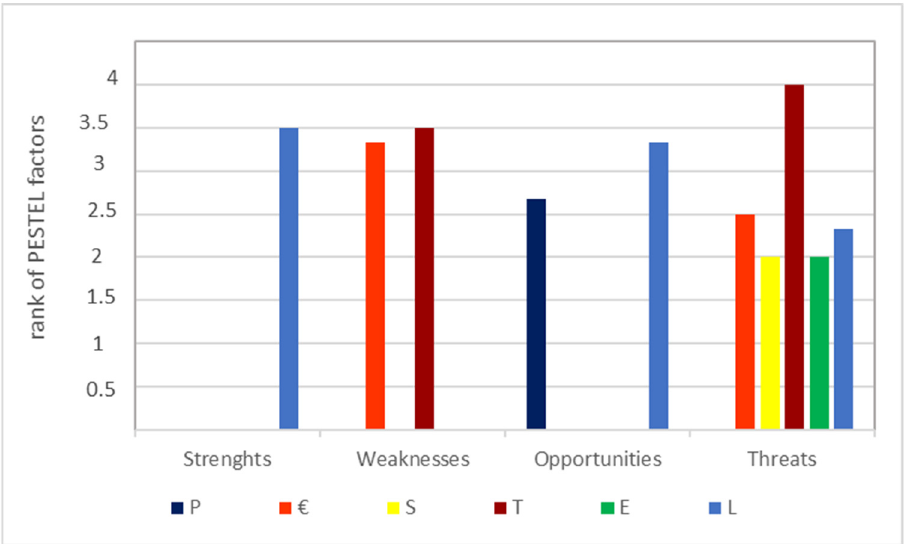
Figure 2. The rank of PESTEL factors in four analysed groups (Strengths, Weaknesses, Opportunities and Threats), where P—political, € —economic, S—social, T—technological, E—environmental and L—legal.